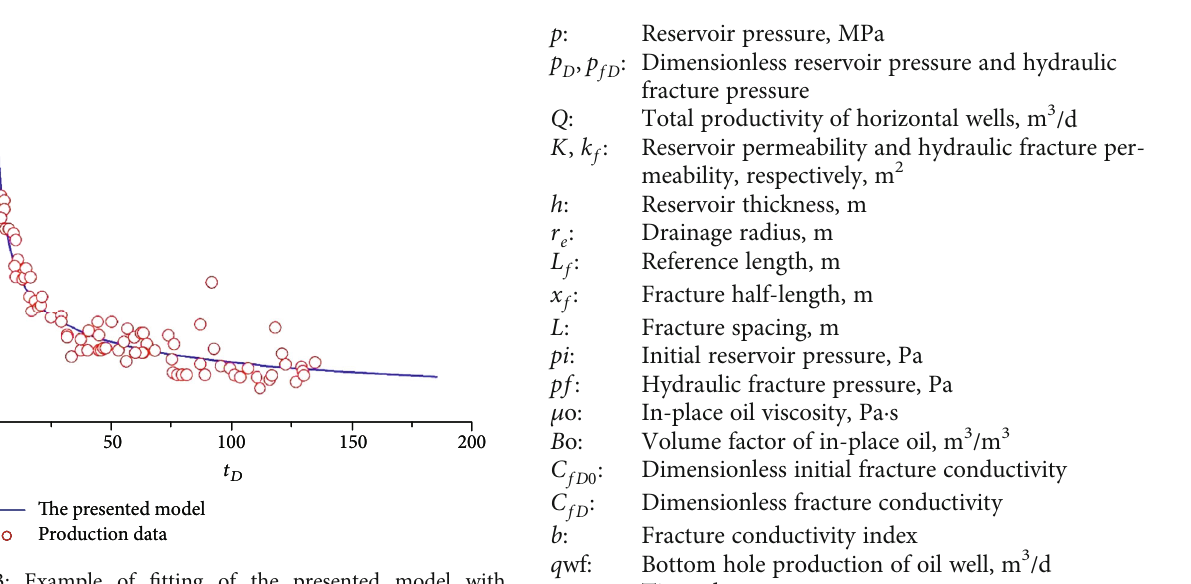
Figure 13: Example of fi tting of the presented model with production